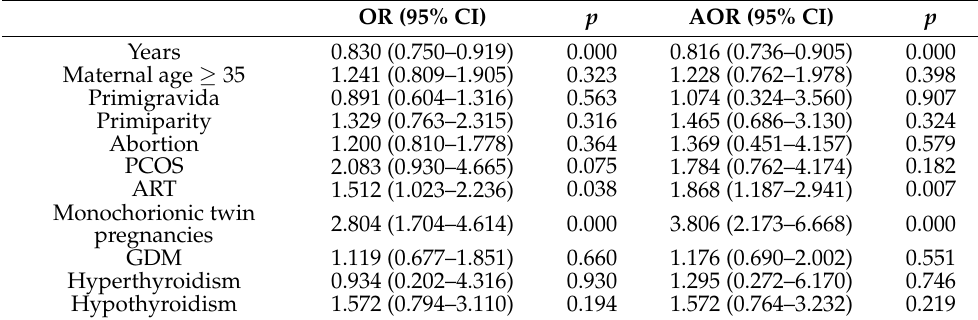
Figure 1. Forest plot showing risk factors for preeclampsia in twin pregnancies. Abbreviations: AOR, adjusted odds ratio; 95% CI, 95% confidence intervals; ART, assisted reproductive technology; PCOS, polycystic ovary syndrome; GDM, gestational diabetes mellitus. We adjusted for years, maternal age, gravidity, parity, abortion, PCOS, chorionicity, GDM, hyperthyroidism, and hypothyroidism. Table 2. Risk factors for preeclampsia in twin